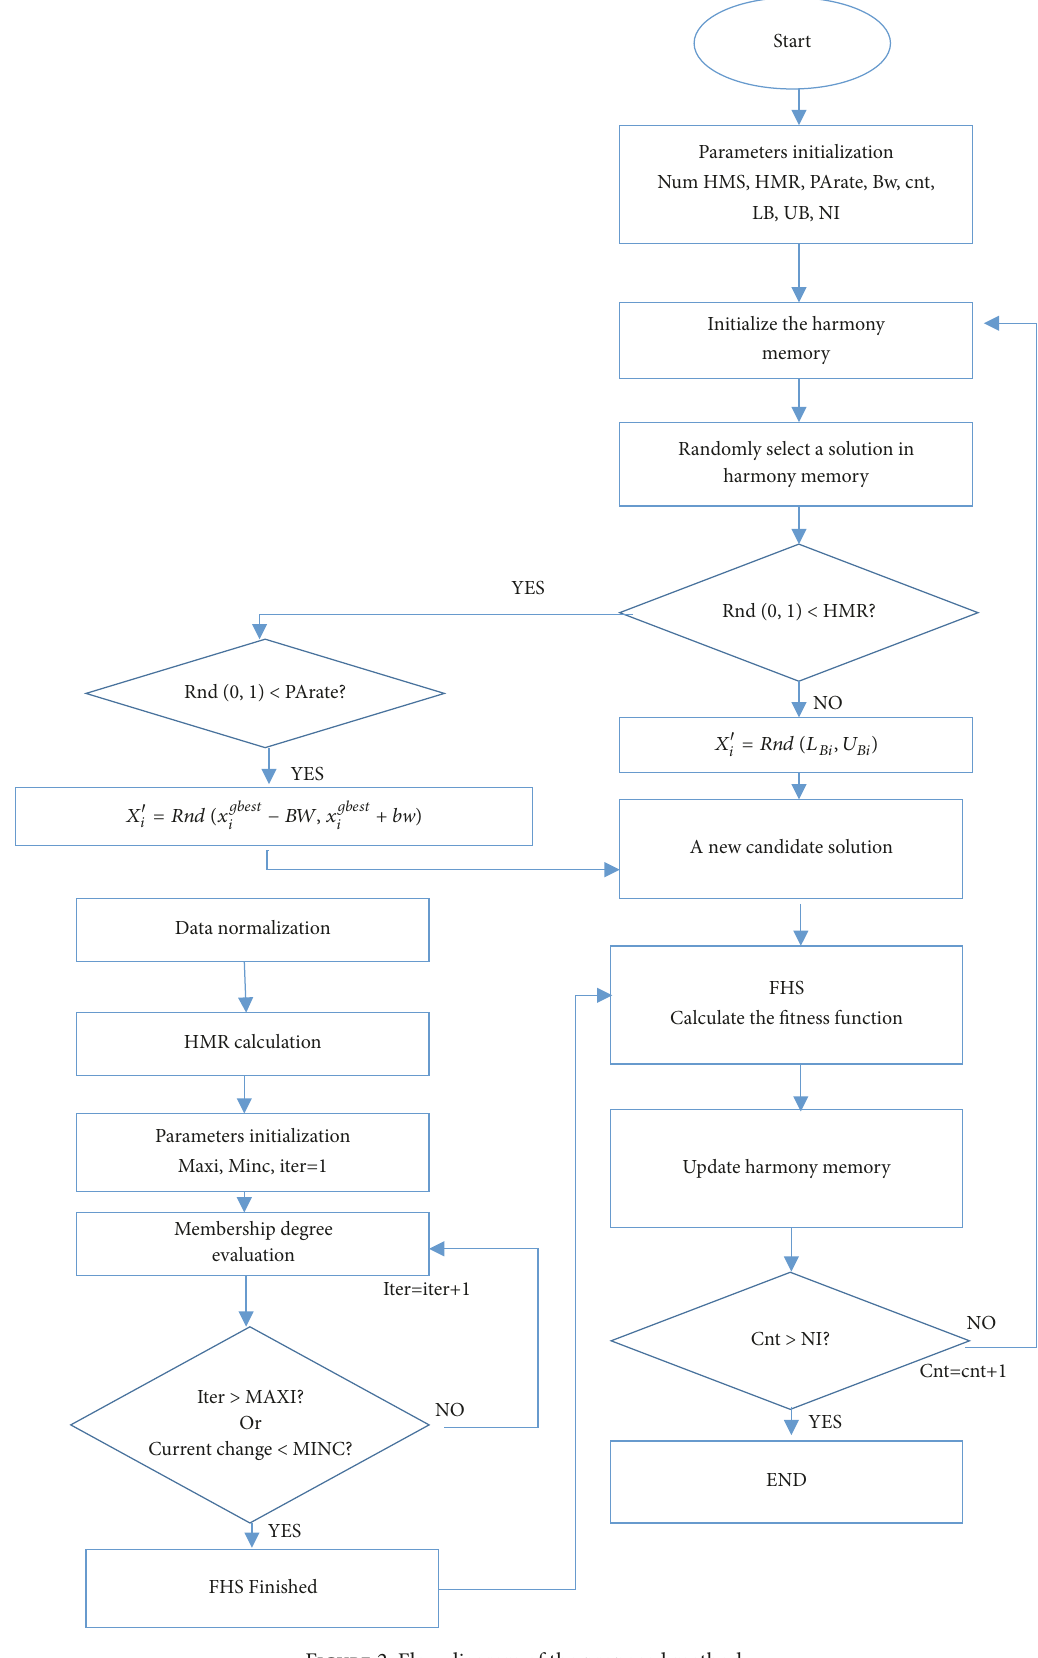
Figure 2: Flow diagram of the proposed